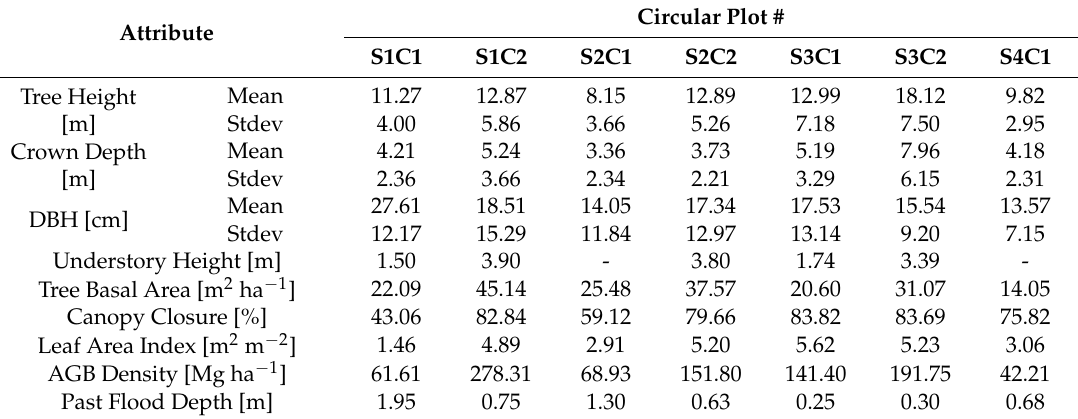
Table A4. Summary of circular plot characteristics.